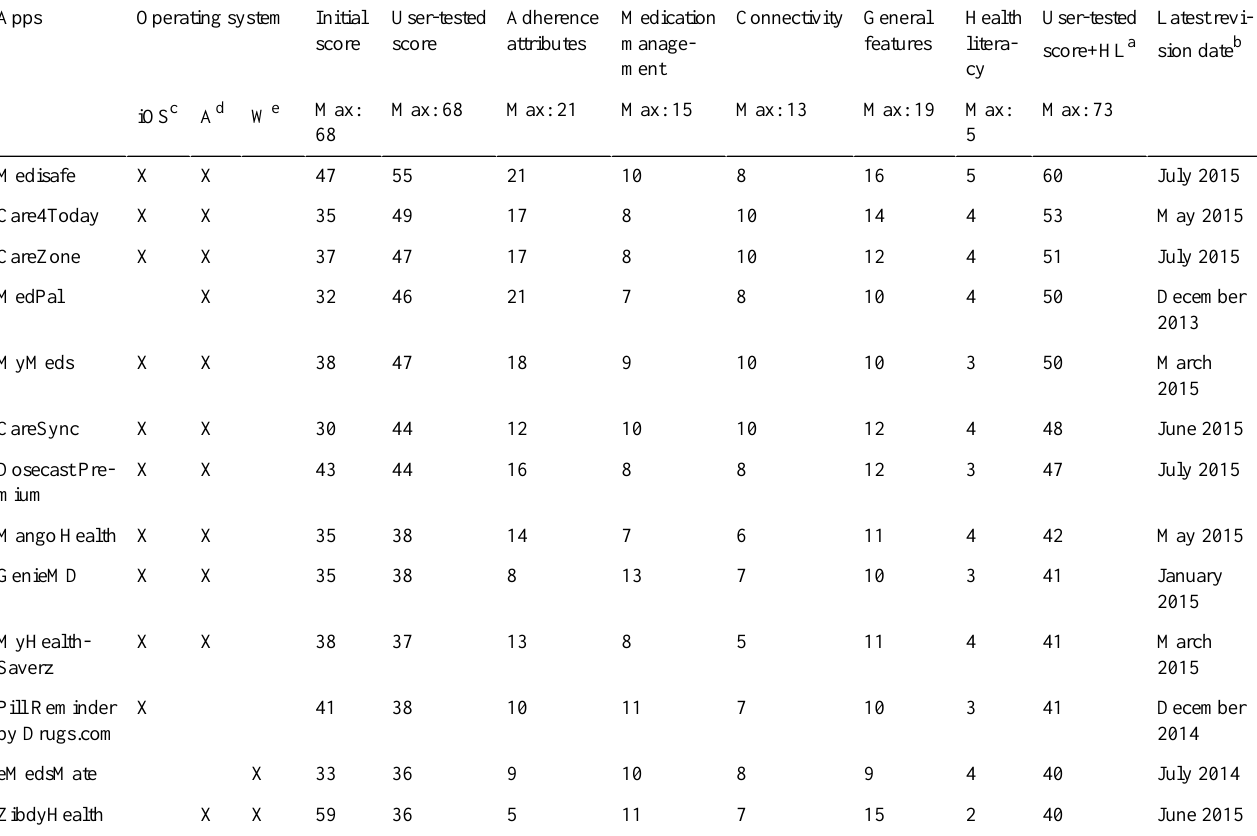
Table 3. Highest-ranking adherence apps’user-tested domain